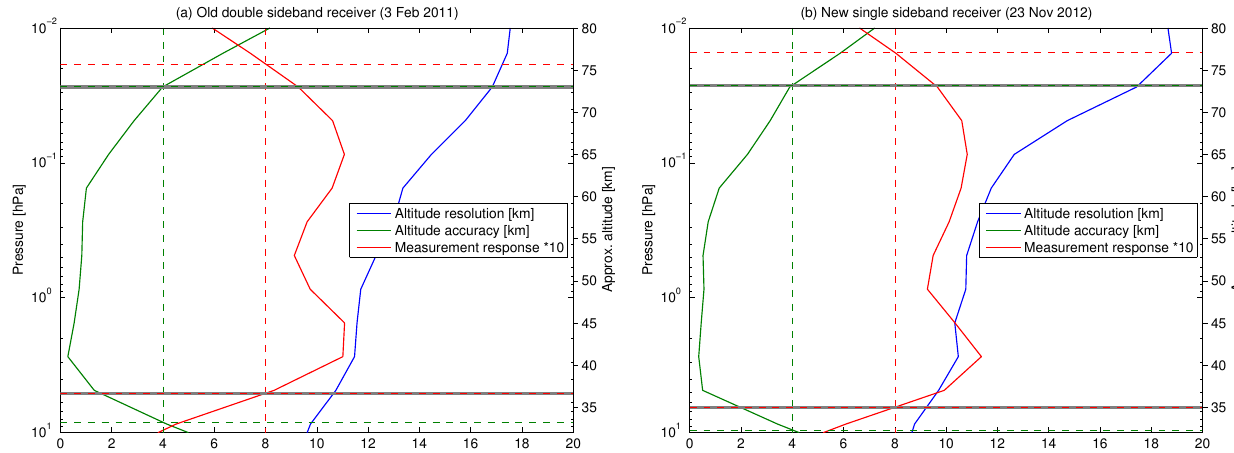
Figure 9. Typical altitude dependence of altitude resolution, altitude accuracy and measurement response of WIRA’s wind retrieval in the double (left) and single sideband mode (right). The horizontal grey lines denote the limits of the trustable altitude range. The dashed lines mark the limits defined by the individual conditions.